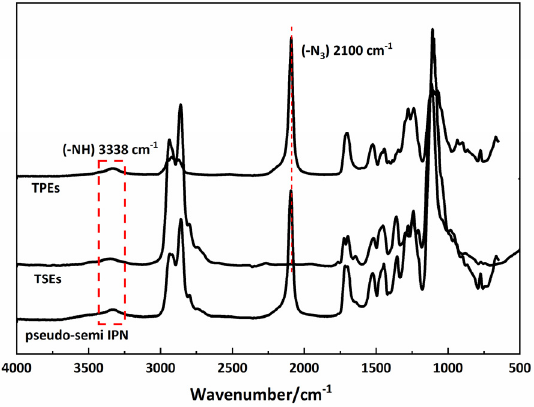
Figure 4. TPEs, TSEs and pseudo-semi IPNs sample FTIR